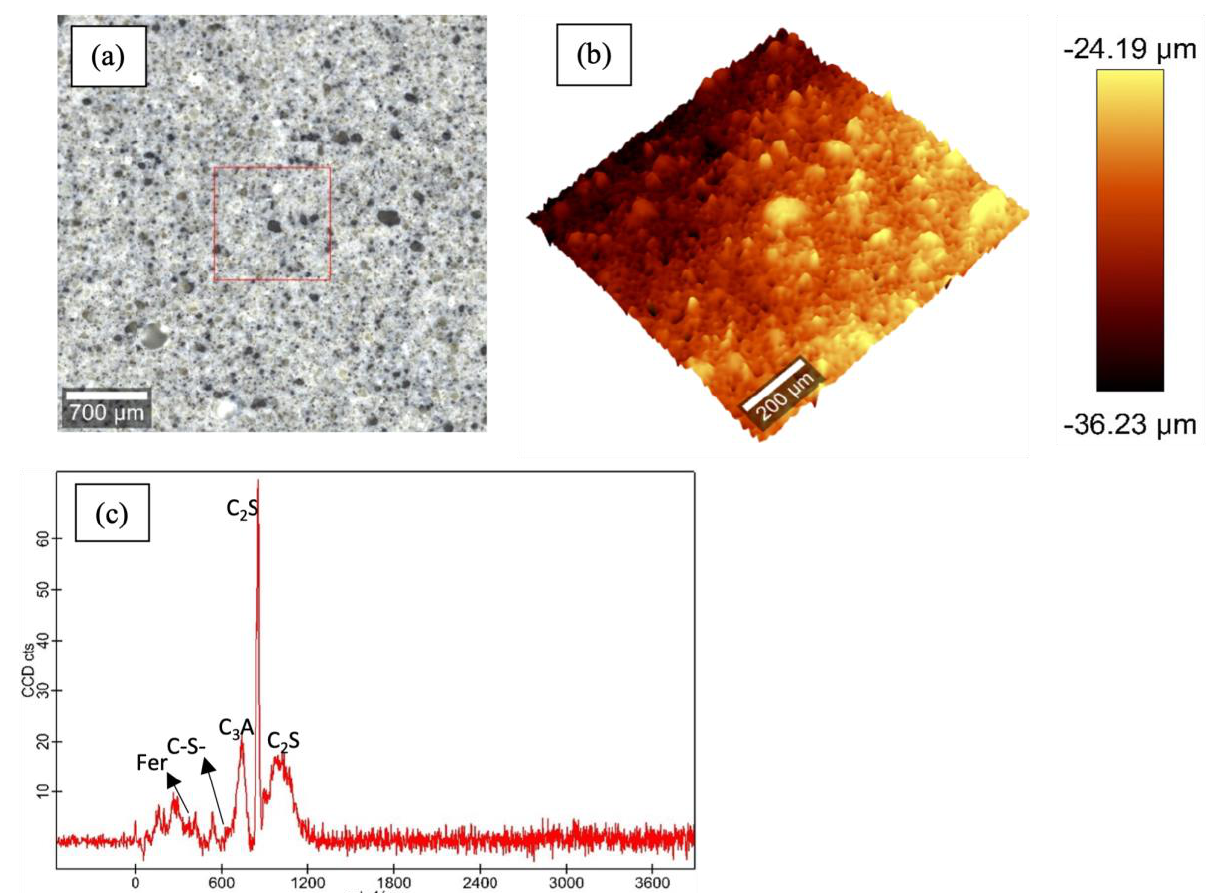
Figure 5. Raman results for polished cores of 15% ferrierite-added Class-H cement: ( a ) optical micrograph of polished cement core; ( b ) large-area profilometry scan of the cement; ( c ) phase peaks identical to those observed in Figure 3 for ferrierite, C-S-H, C 3 A and C 2 S.